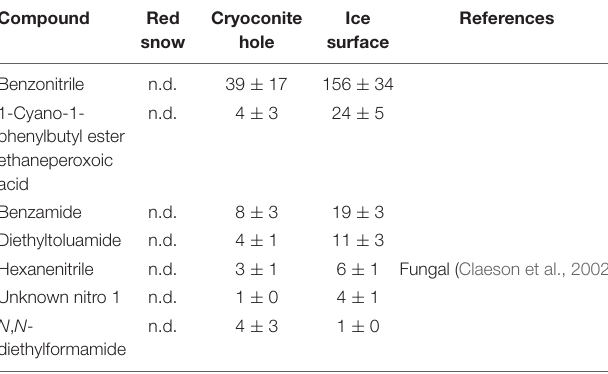
TABLE 5 | Mean (ng m − 2 h − 1 ± SE) nitrogen-containing VOC emissions measured in three microbiological habitats on the southern Greenland ice sheet. Compound Red Cryoconite Ice snow hole